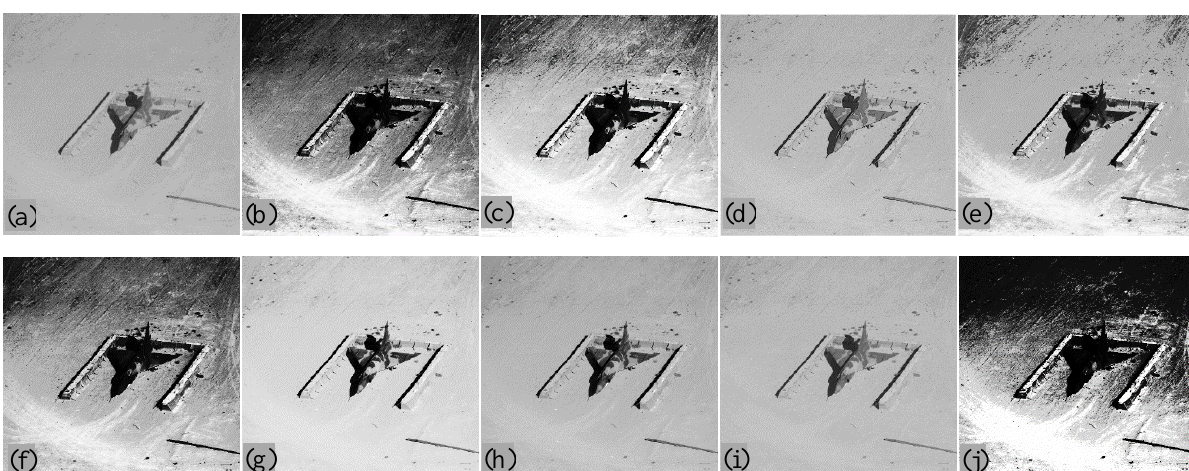
Figure 12. Plan (a) Original Image (b) Enhanced image by Histogram Equalization (c) Enhanced image by BBHE (d) Enhanced image by ABC (e) Enhanced image by RSIHE (f) Enhanced image by DSIHE (g) Enhanced image by [19] (h) Enhanced image by proposed method (i) Enhanced image by SDDMHE (j) Enhanced image by